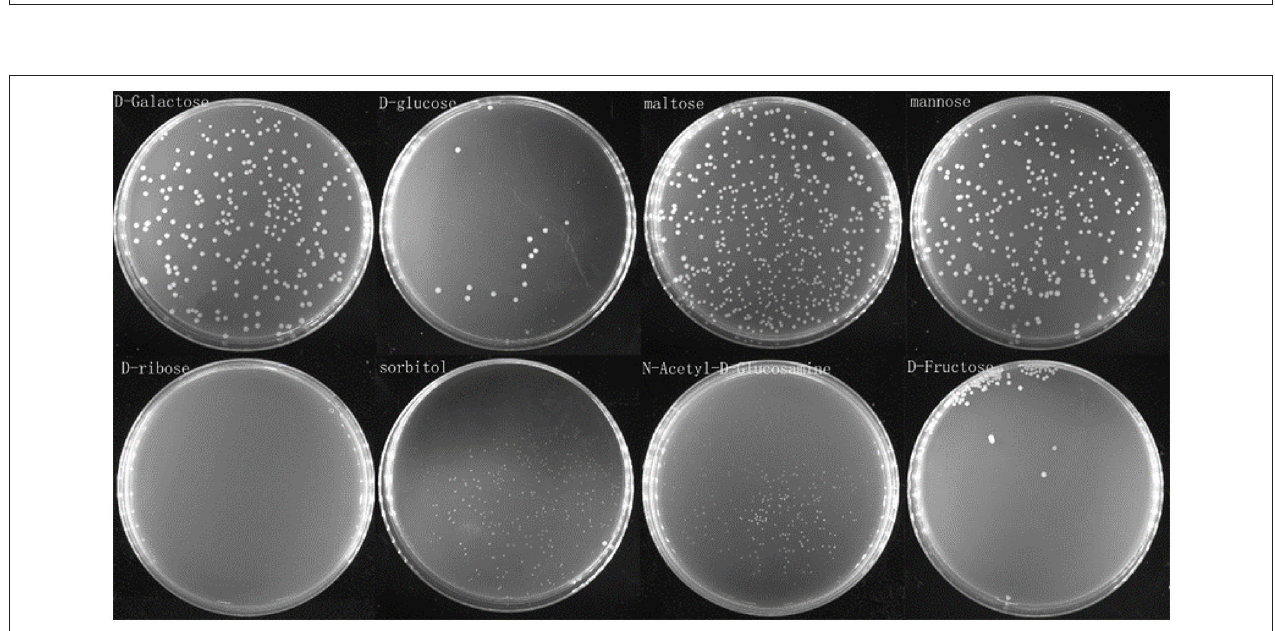
FIGURE 4 | Persister cells wake up on plate containing single amino acid. V. splendidus persister cells were incubated at 28 ◦ C for 96h on M9 minimal plate with 15 individual amino acids (L-alanine, L-serine, L-cystine, L-arginine, L-lysine, L-phenylalanine, L-asparagine, L-proline, L-isoleucine, L-tryptophan, L-glutamine, L-leucine, L-aspartic acid, L-methionine, and L-glutamic acid). The concentrations of the amino acids in the experiment were 5 × concentration as listed in Table 1 .